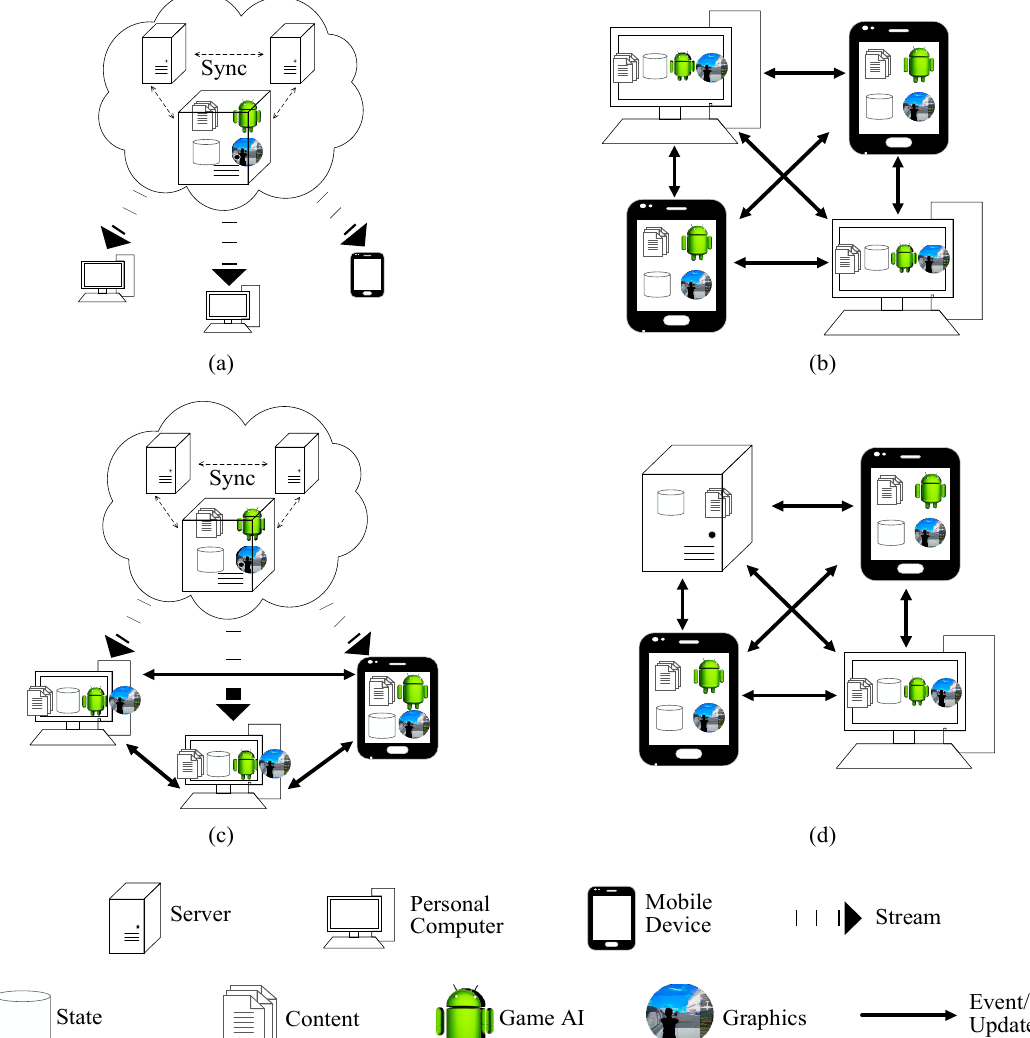
Figure 8. Conceptual models of virtual world architectures: ( a ) client/server (C/S), ( b ) peer-to-peer (P2P), ( c ) Hybrid-I, and ( d ) Hybrid-II.